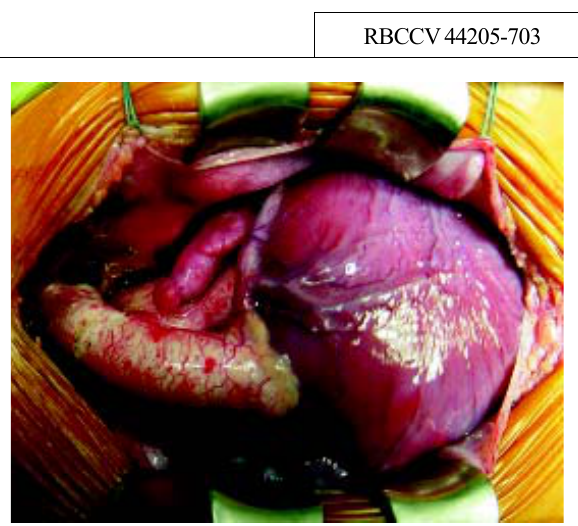
Fig. 1 – Aspecto intra-operatório no qual se observa a aorta anterior coronário 1. O tronco pulmonar é posterior e muito